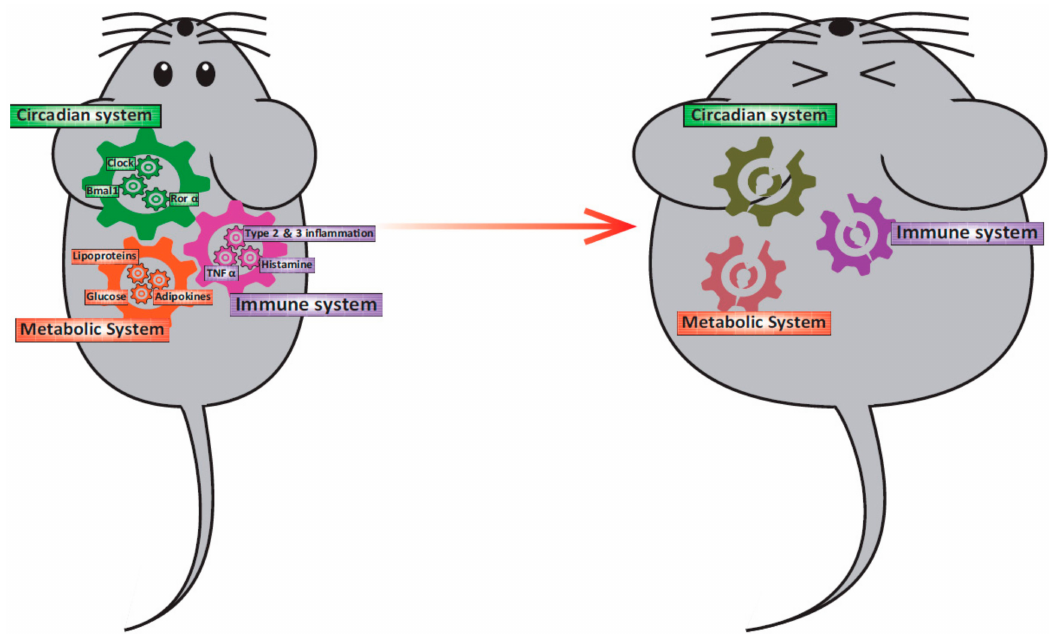
Figure 1. Relationship among the circadian clock system, obesity, and immunity. In a healthy state, the circadian clock system, the metabolic system, and the immune system interact and function normally. However, when one of the gears became out of position for some reason, other systems will be led to